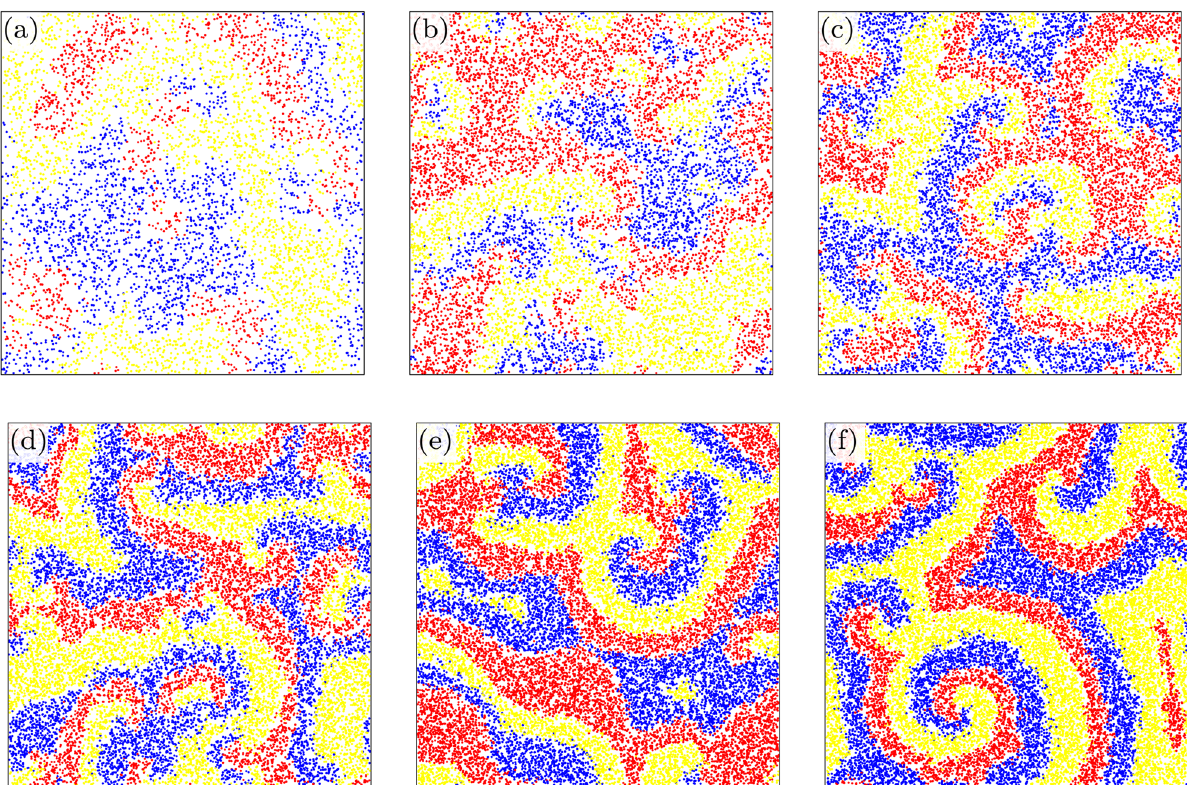
Figure 1. Characteristic spatial distributions of species, for different values of the local carrying capacity M . Here red, blue, and yellow dots represent the three competing species, while the empty space is marked by white. The snapshots were taken after 10 8 MC steps. The actual values of M is 5 ( a ), 10 ( b ), 15 ( c ), 20 ( d ), 25 ( e ), and